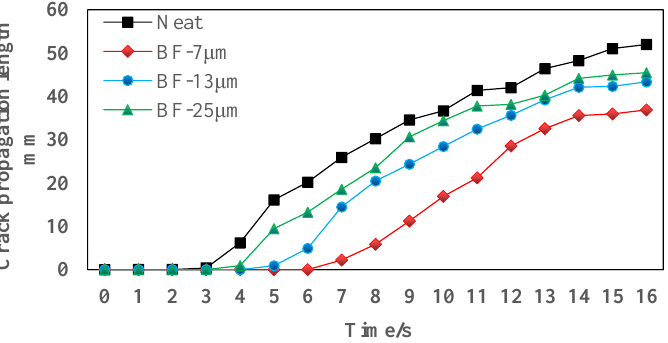
Figure 17. Crack propagation length of the specimen.